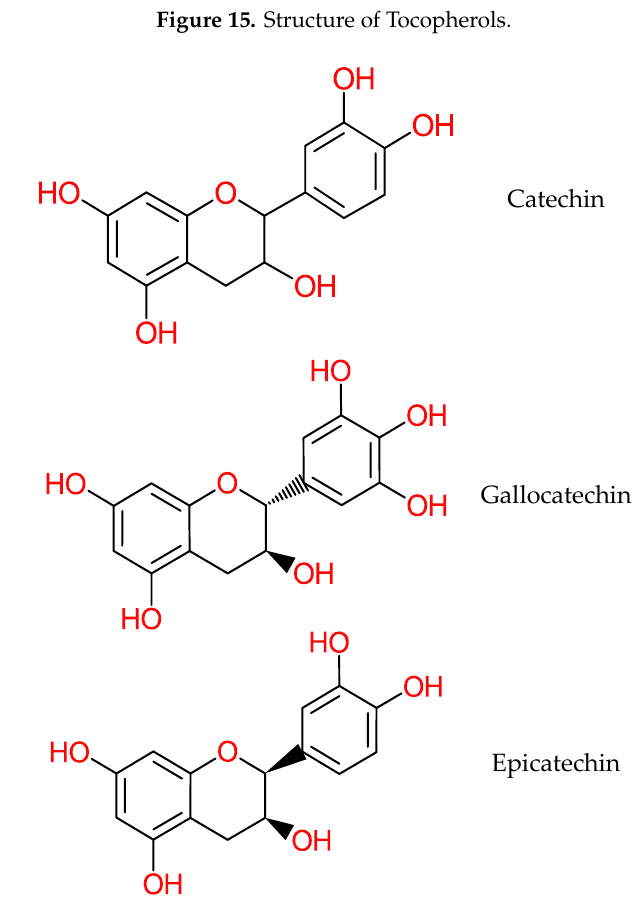
Figure 15. Structure of Tocopherols.